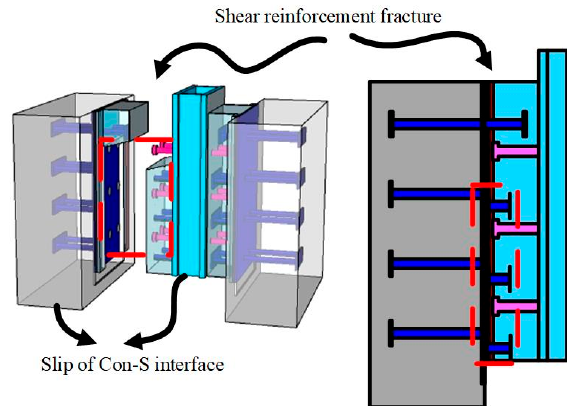
Buildings 2023 , 13 , x FOR PEER REVIEW Figure 11. Typical failure form of specimens. Figure 11. Typical failure form of specimens.